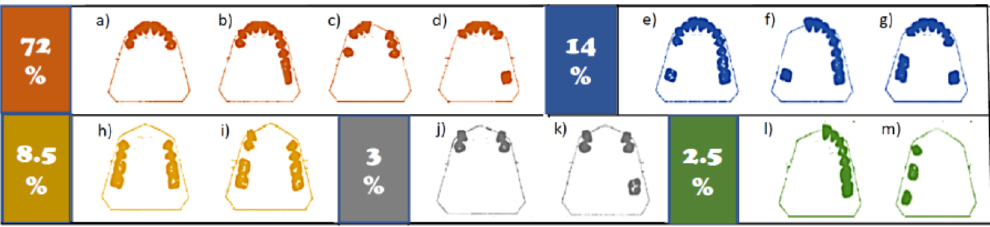
Figure 1. Classes I–IV of dental deficiencies together with the frequency of individual groups of digestive system diseases defects (on colored fields): I—two-sided areas of the toothless alveolar ridge located behind the patient’s last teeth (bilateral absence of the wing), II—a one-side area of the toothless alveolar ridge located behind the patient’s last teeth (unilateral lack of the arm), III—a one-sided area of the toothless alveolar ridge limited at the front and back of the patient’s teeth (interdental deficiencies), IV—a single, two-sided, intersecting the median line area of the toothless alveolar ridge located forward from the patient’s teeth (deficiencies front teeth); according to B—Bailyn, K—Kennedy, S—Skinner; ( a ) IK, IIB, IIIS; ( b ) IIK, IIB, IIIS; ( c ) Imed2K, IIB, IIIS; ( d ) IImed1K; ( e ) IIIK, IB,